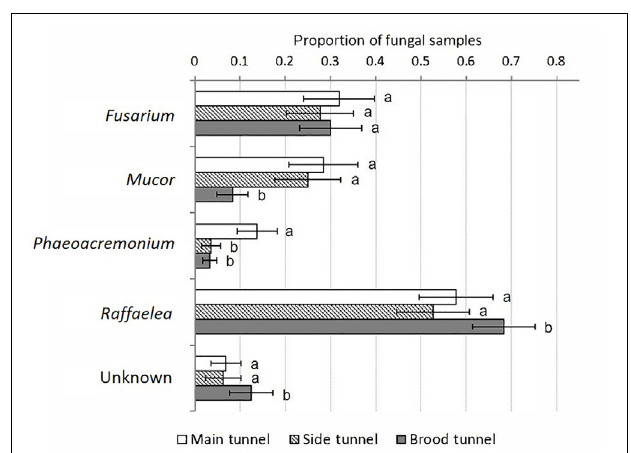
FIGURE 5 | Percentage of fungal morphospecies isolated relative to the total number of samples taken per gallery compartment. Mean ± SE; N = 12 samples per compartment; main tunnel – eight galleries, side tunnel – six galleries, brood tunnel – seven galleries. Different letters denote significant differences ( p < 0.05; for exact values see Supplementary Table S6 ) in pairwise comparisons between